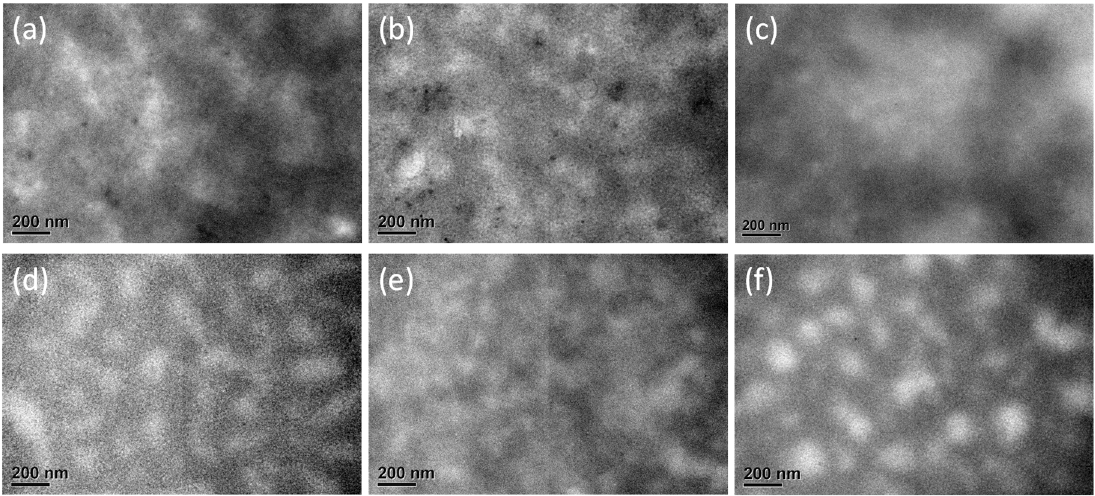
Figure 7. TEM images of ( a ) P1:PC 71 BM, ( b ) P2:PC 71 BM, ( c ) P3:PC 71 BM, ( d ) P1:ITIC, ( e ) P2:ITIC, and ( f ) P3:ITIC blend films.